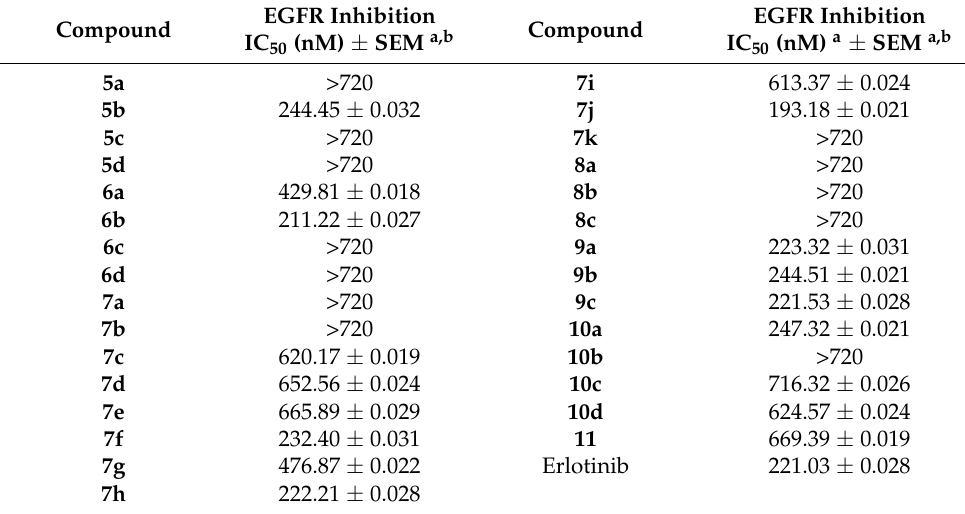
Table 1. In vitro EGFR inhibitory activity of compounds 5 – 11